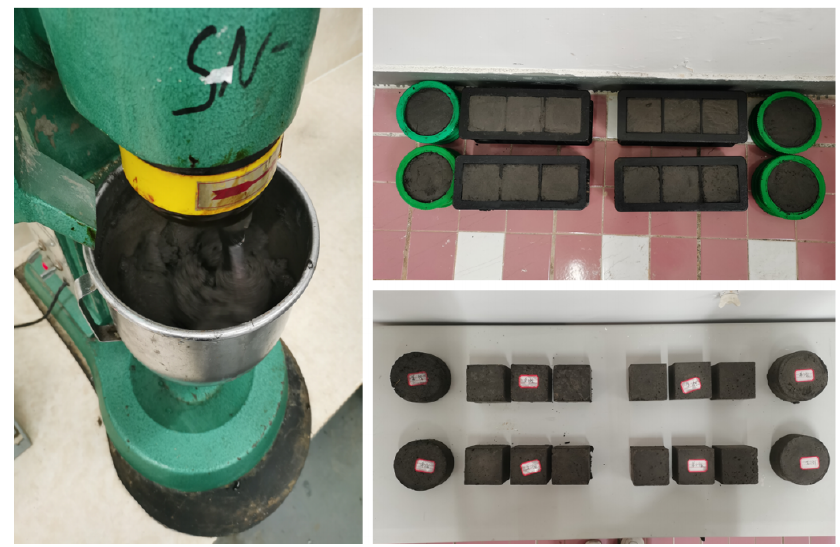
Figure 5. Preparation and curing of specimens.